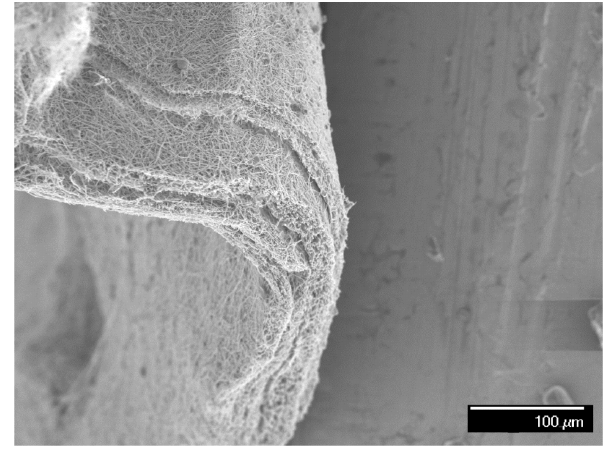
Figure 4. Cross-sectional SEM image of the as-spun PAN nanofiber mat.